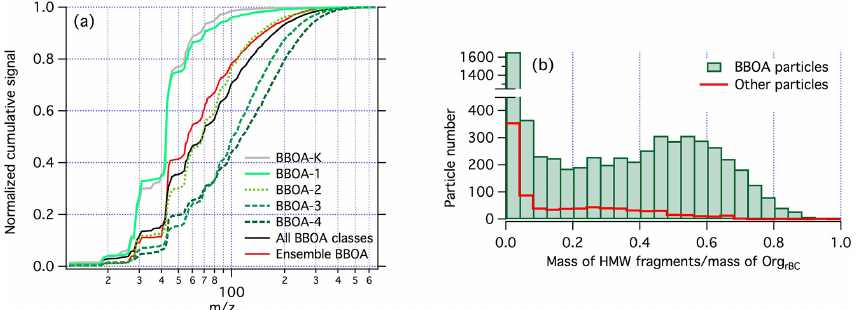
Figure 4. (a) Normalized cumulative histogram of mass-to-charge ratios for each BBOA-related particle class. (b) Histograms of the mass fraction of HMW organic fragments (> m/z 100) in different particle